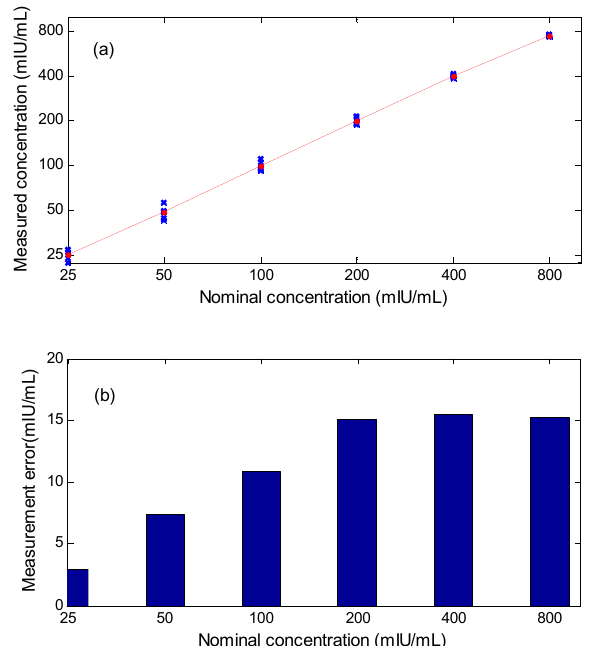
Figure 9. Experimental results for the measurement of standard strips. ( a ) measured concentration vs. nominal concentration. X-crosses: result of one single measurement; dots: average of five measurements; ( b ) measurement error.